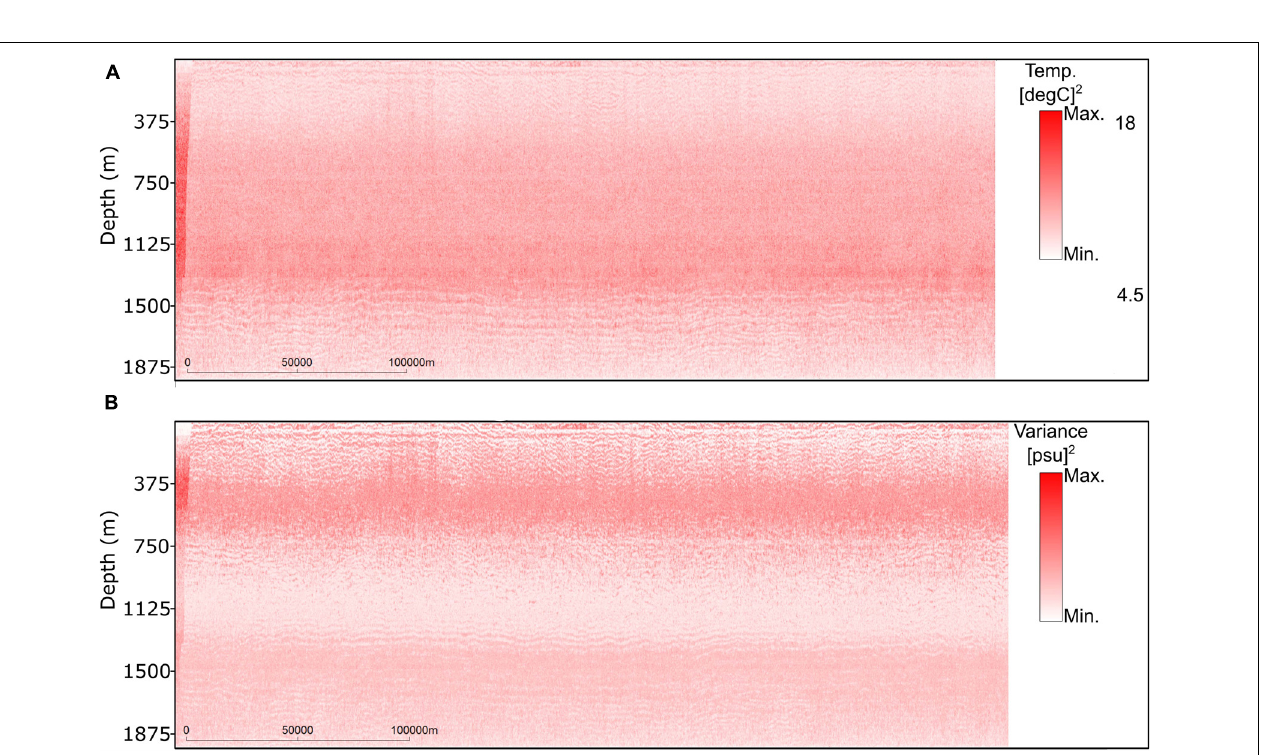
FIGURE 13 | Pointwise variance model of the set of inverted (A) temperature and (B) salinity models generated during the last iteration of the geostatistical inversion.